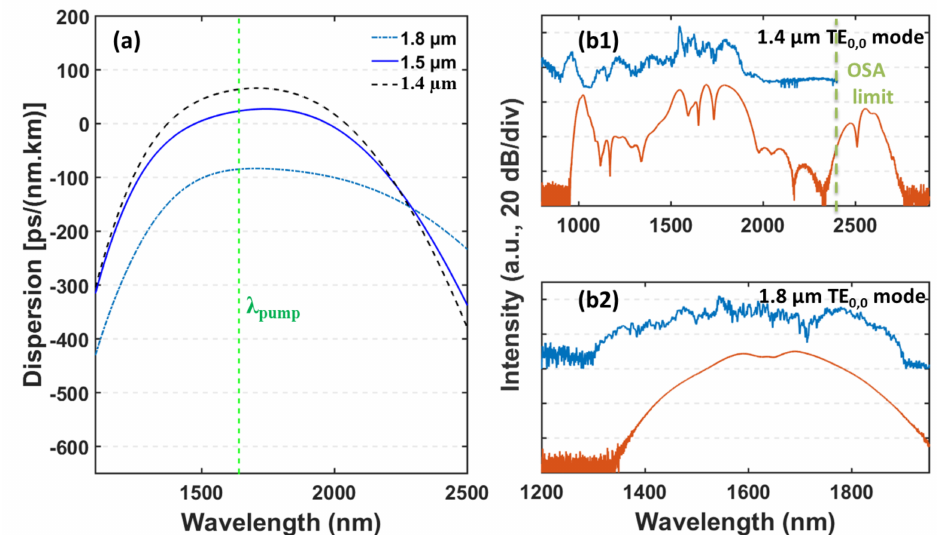
Figure 6. ( a ) Dispersion profiles of the fundamental TE 0,0 mode of the waveguide for different widths (1.4, 1.5 and 1.8 µ m). ( b ) Experimental spectra (blue lines) and corresponding numerical simulations (red lines) for ( b1 ) 1.4 µ m and ( b2 ) 1.8 µ m. For the clarity of the figure, the various spectra were vertically